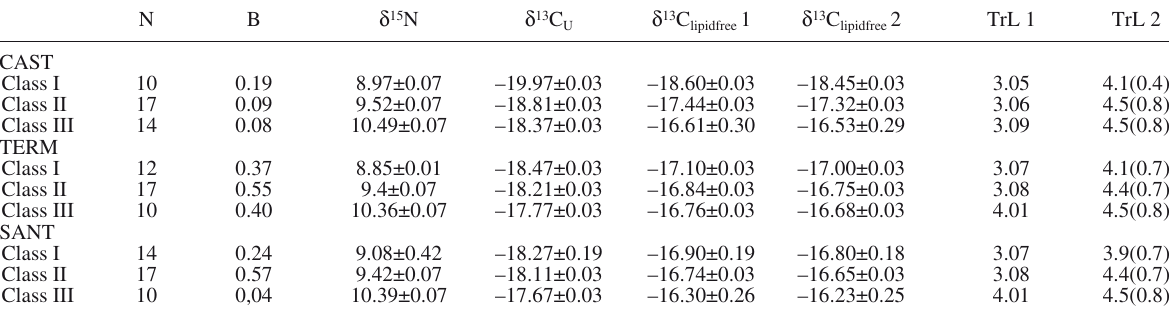
Table 3. – Number of prey taxa (N) found in the stomach contents of hake from the three gulfs and for each size class. Values of niche breadth (B) according to the Levins index from the three gulfs and for each size class. δ 15 N and δ 13 C and for each size class. Values of δ 13 C corrected for lipid content according to model 1 ( δ 13 C further details). Trophic level estimated on the basis of δ 15 N values of hake: TrL 1 was calculated considering calanoid copepods as reference material; TrL 2 was calculated using TrophLab (see text for details). GCAST, Gulf of Castellammare; GTERM, Gulf of Termini Imerese; GSANT, Gulf of Sant’Agata. Class I, hake 60-120 mm TL; Class II, hake 121-220 mm TL; Class III, hake 221-410 mm TL.